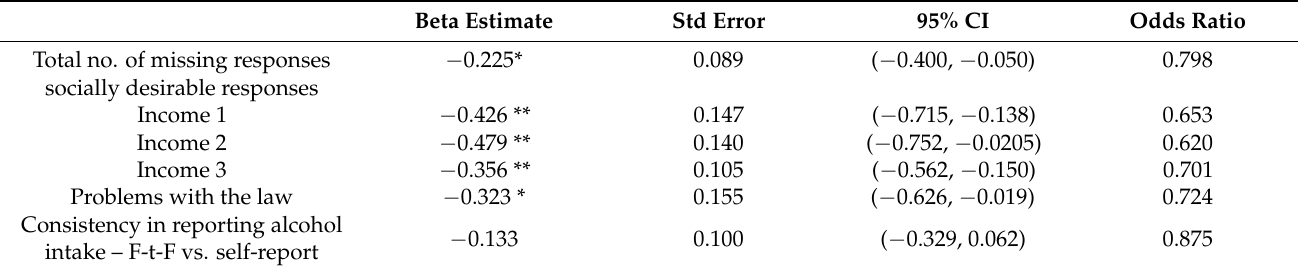
Table 3. Association between rapport and data quality assessed with GEE analysis, * p < 0.05, ** p <